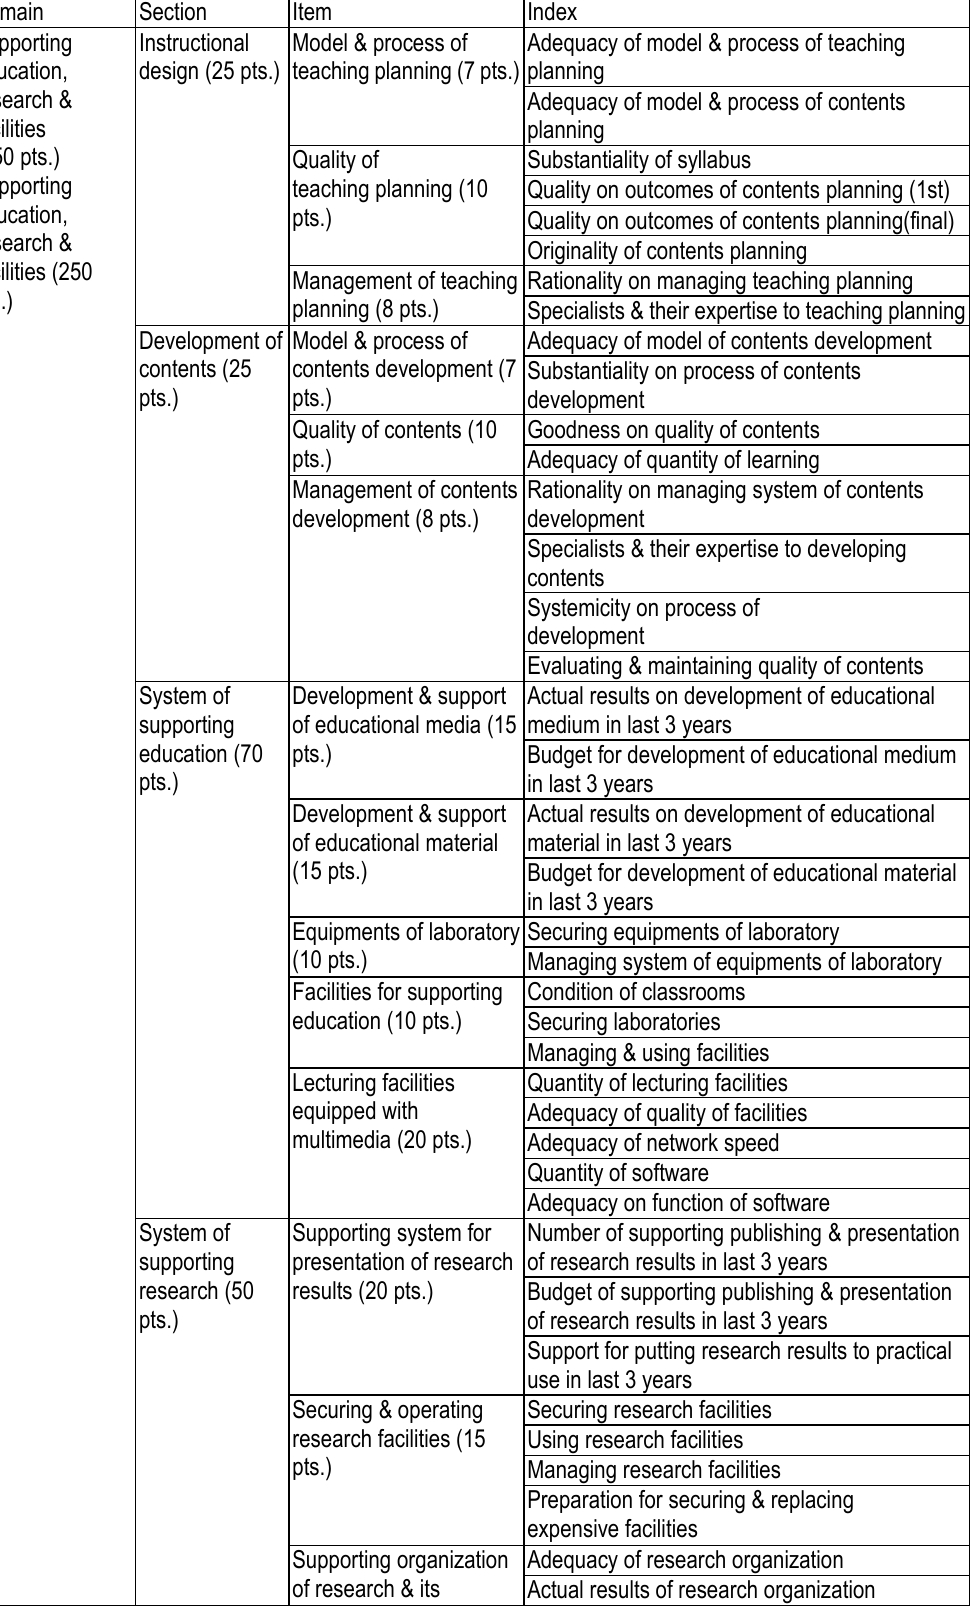
Table 5. Supporting education, research & facilities